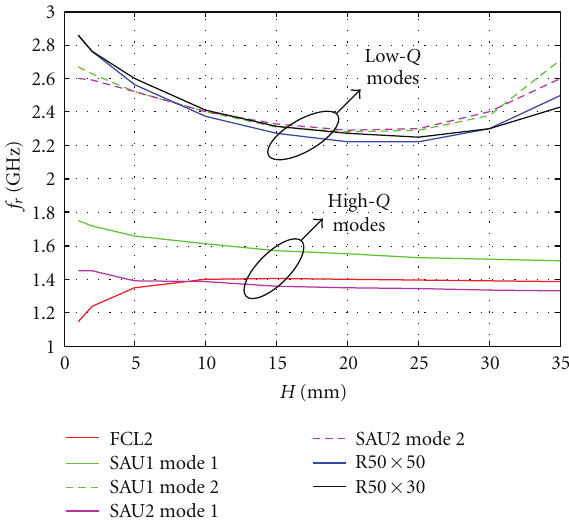
Figure 16: Characteristic angles for the FCL2 structure at H = 29mm.